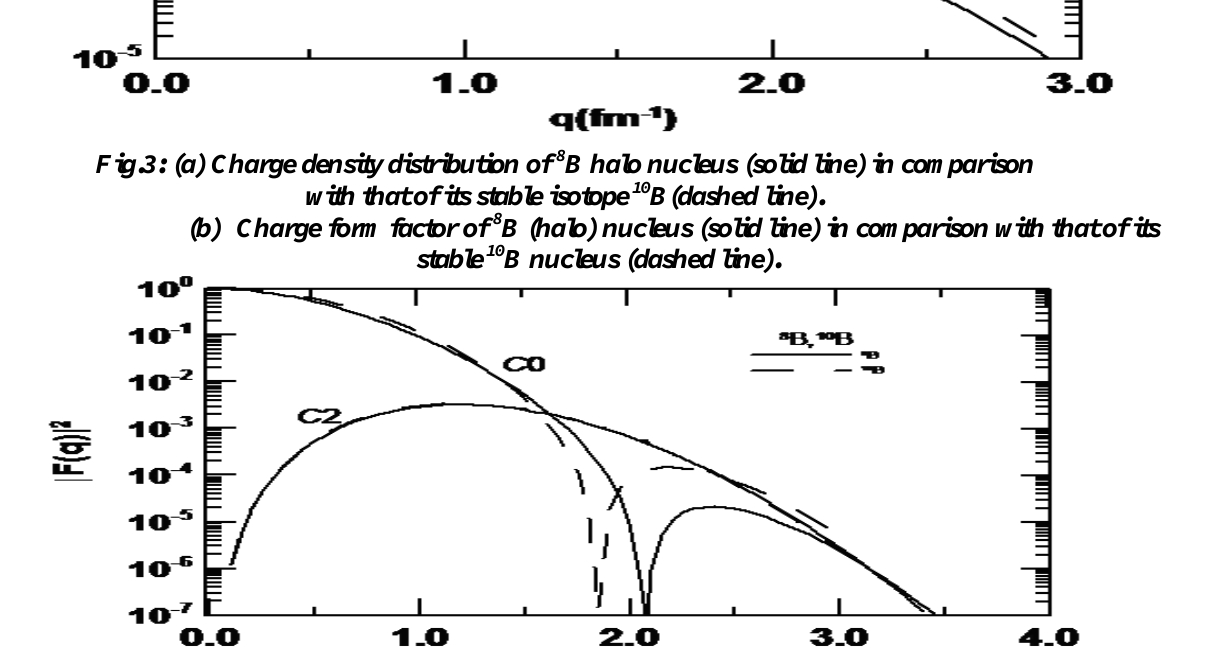
Fig.4: C0 and C2 form factors of 8 B (halo) nucleus (solid lines) in comparison with those of 10 B nucleus (dashed